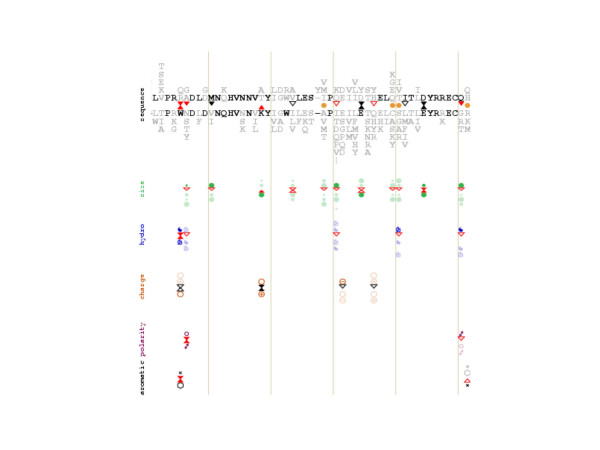
A portion of the CPDL [12] output for the FatA (upper) versus FatB (lower) alignment. Arrows denote residues that are conserved in all or "all-but-one" of the sequences in each class. One of the putative SDPs examined in this study (W221R) is flagged with a red hourglass.